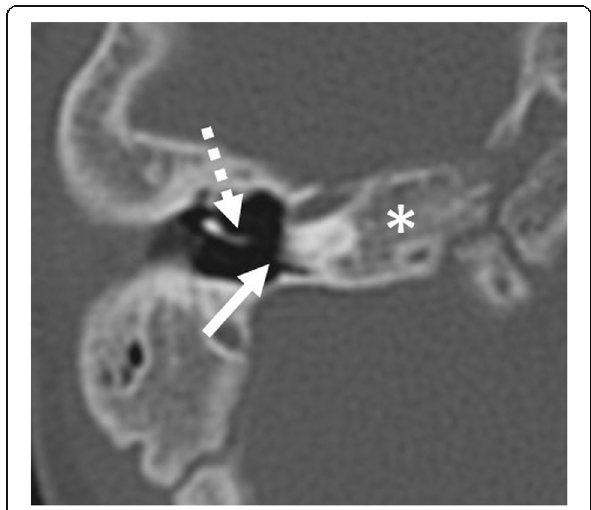
Fig. 4 A 1-year-old male patient, with bilateral sensorineural deafness from birth. HRCT axial image shows hypoplastic right petrous bone with a complete absence of the inner ear structures (asterisk), compatible with Michel ’ s deformity. The medial wall of the middle ear is flat (arrow). Absent round and oval windows. Absent stapes. Normal-looking malleus (dashed arrow)